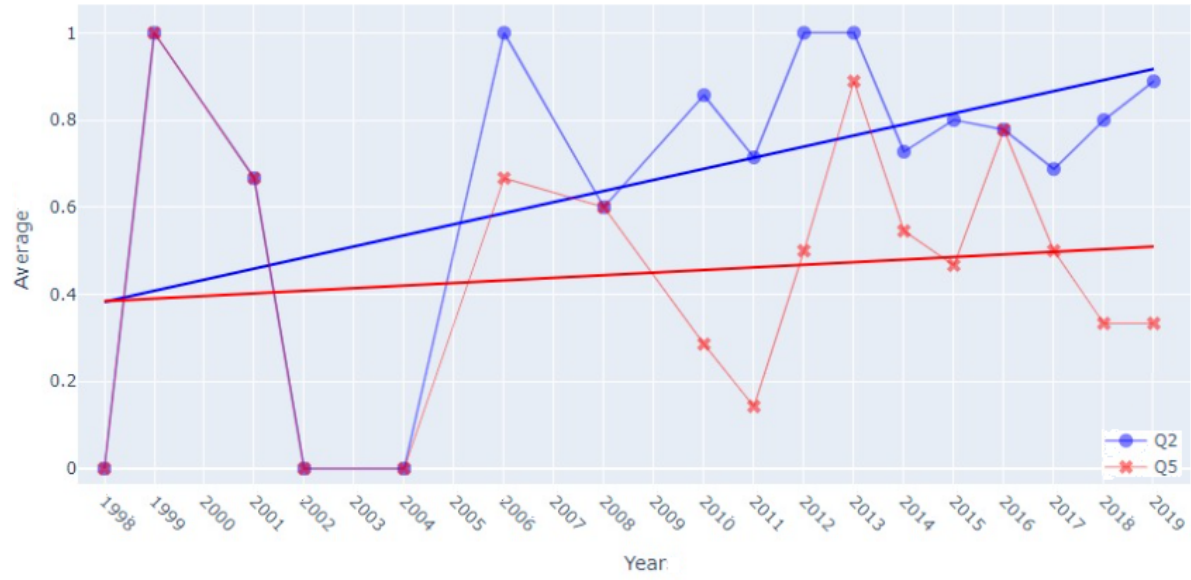
Figure 13. Score distribution and trend over years of Q2 and Q5 when their answers was